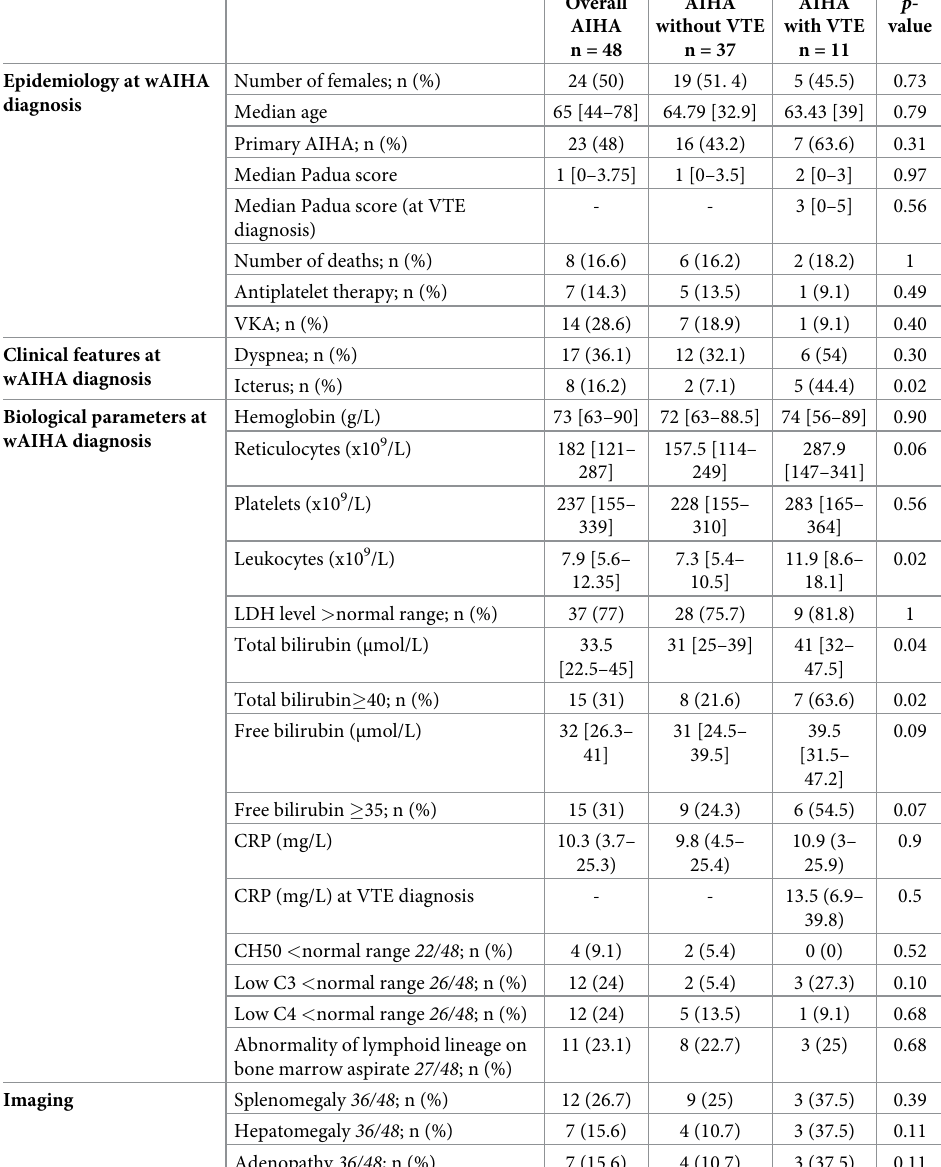
Table 2. wAIHA baseline characteristics in the whole cohort and comparison between patients with or without